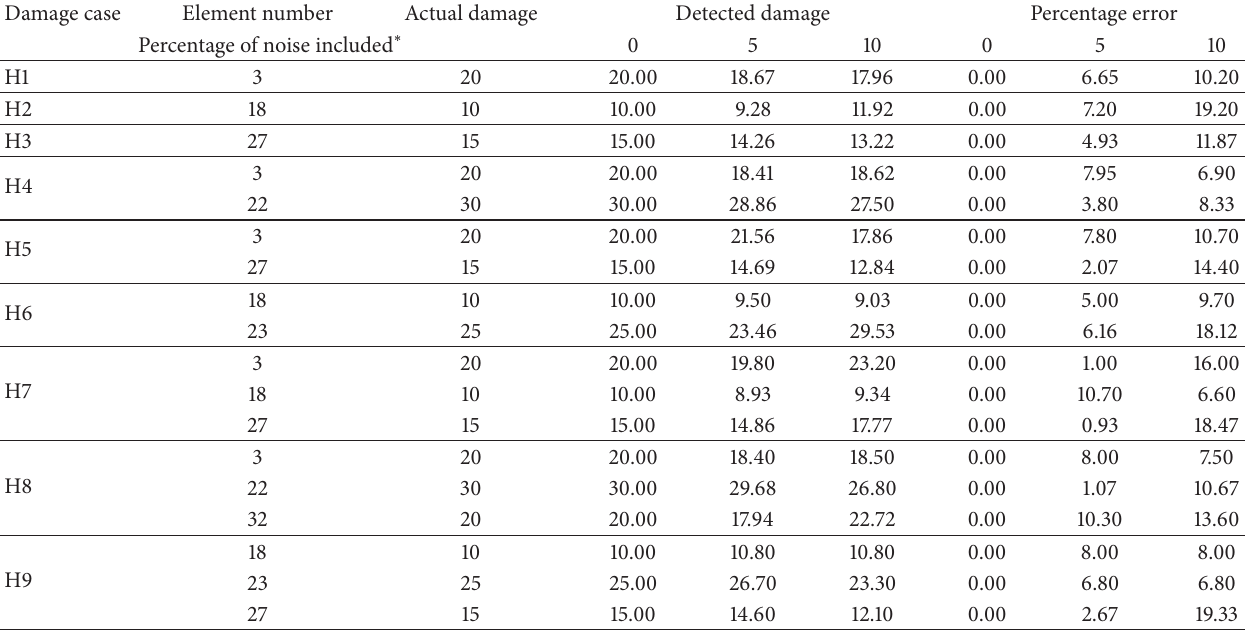
Table 11: Multiple damage detection in space frame structure.